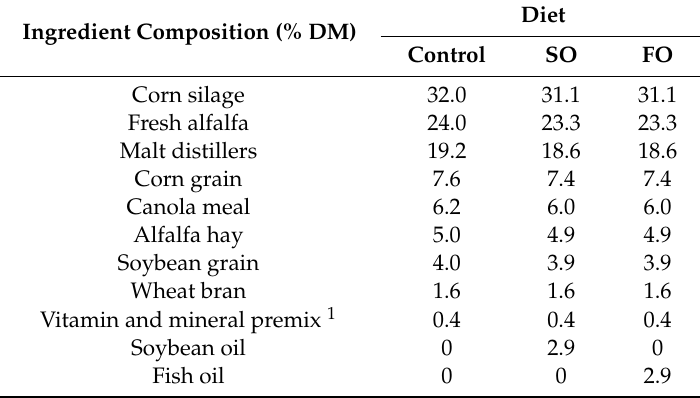
Table 1. Ingredients of control, soybean oil (SO), and fish oil (FO) dietary treatments. Diet Ingredient Composition (% DM) Control SO FO Corn silage